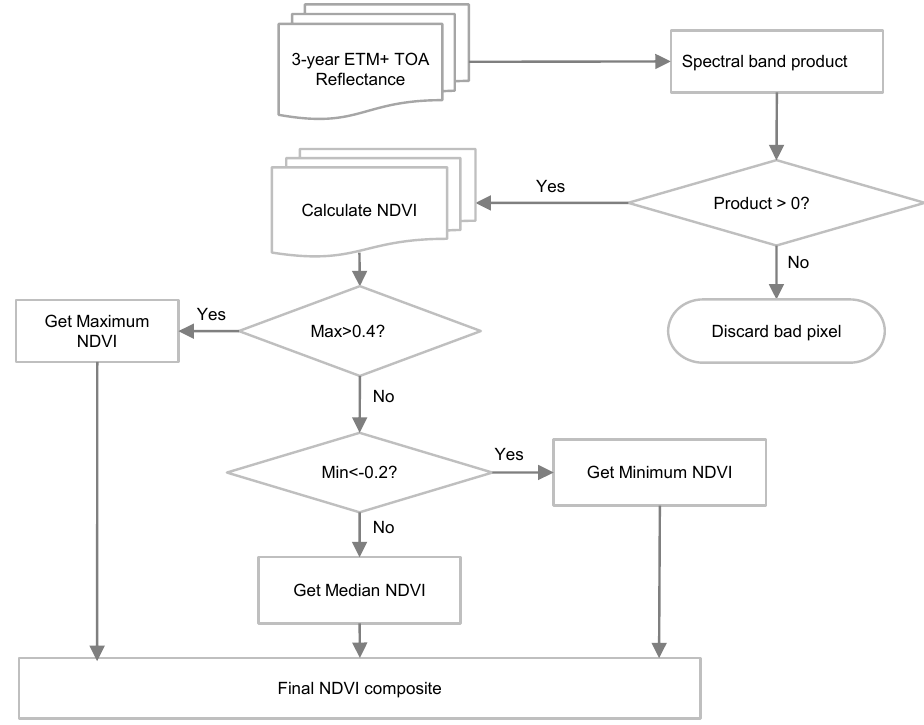
Figure 4. The procedure to generate NDVI composites from multi-year Landsat-7/ETM+ imagery with the proposed Mixed NDVI method on Google Earth